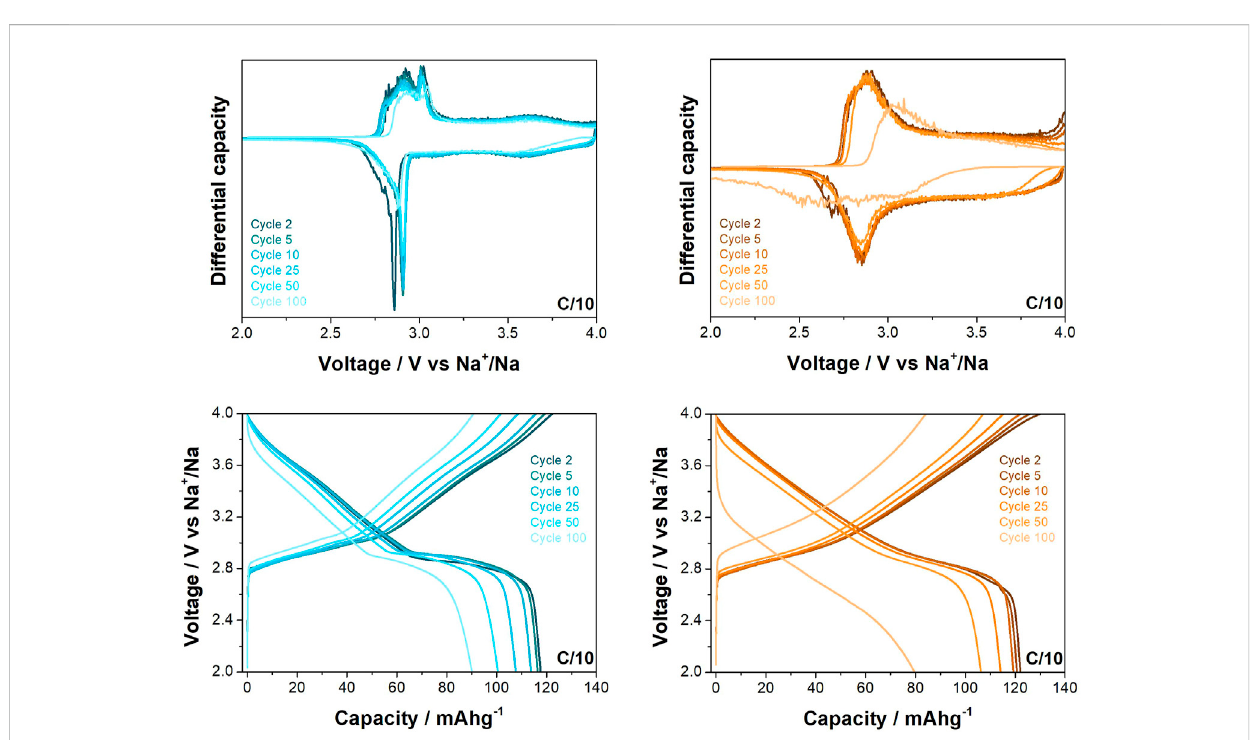
FIGURE 4 Differential capacity plots and load curves for O3-NaNMFO-SS (dark turquoise) and O3-NaNMFO-SG (orange) at C/10.